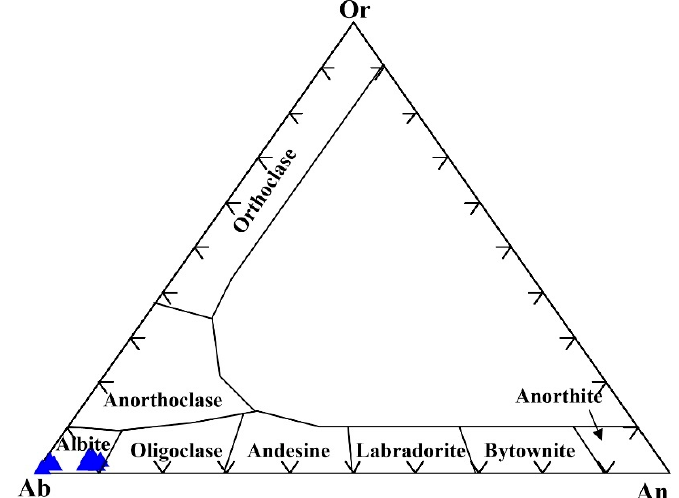
Figure 7. Feldspar (anorthite [An]-albite [Ab]-orthoclase [Or]) compositional diagram to nomenclature the plagioclase series [60].